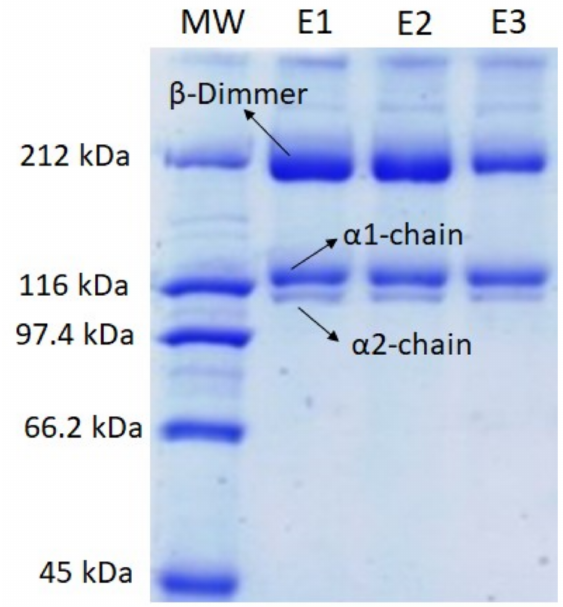
Figure 1. SDS-PAGE profile of Blue shark collagen obtained in three sequential extraction steps (E1, E2,